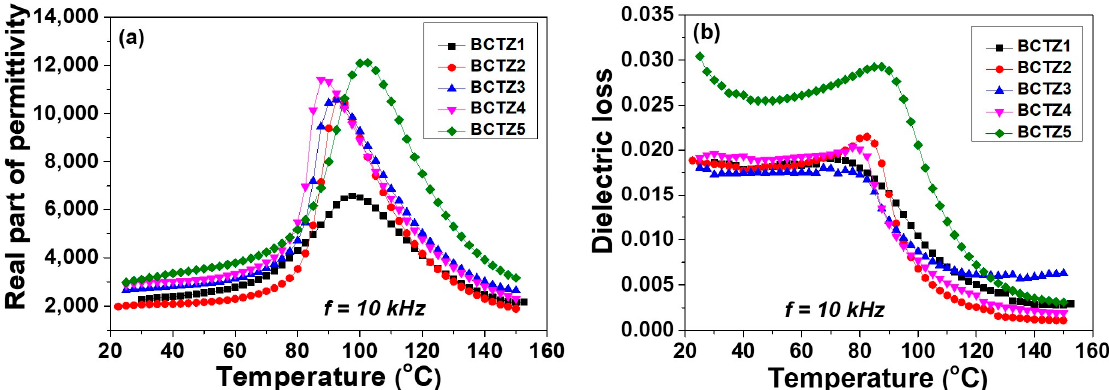
Figure 3. Real part of the dielectric constant ( a ) and tangent loss vs. temperature ( b ) for all of the BCTZ ceramic samples, measured at 10 kHz frequency.